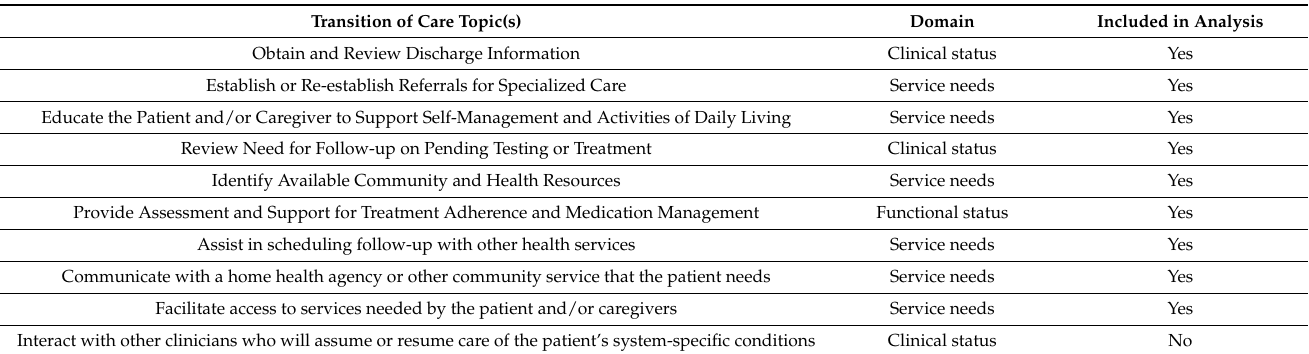
Table 1. Transition of Care Topics’ Inclusion in Study